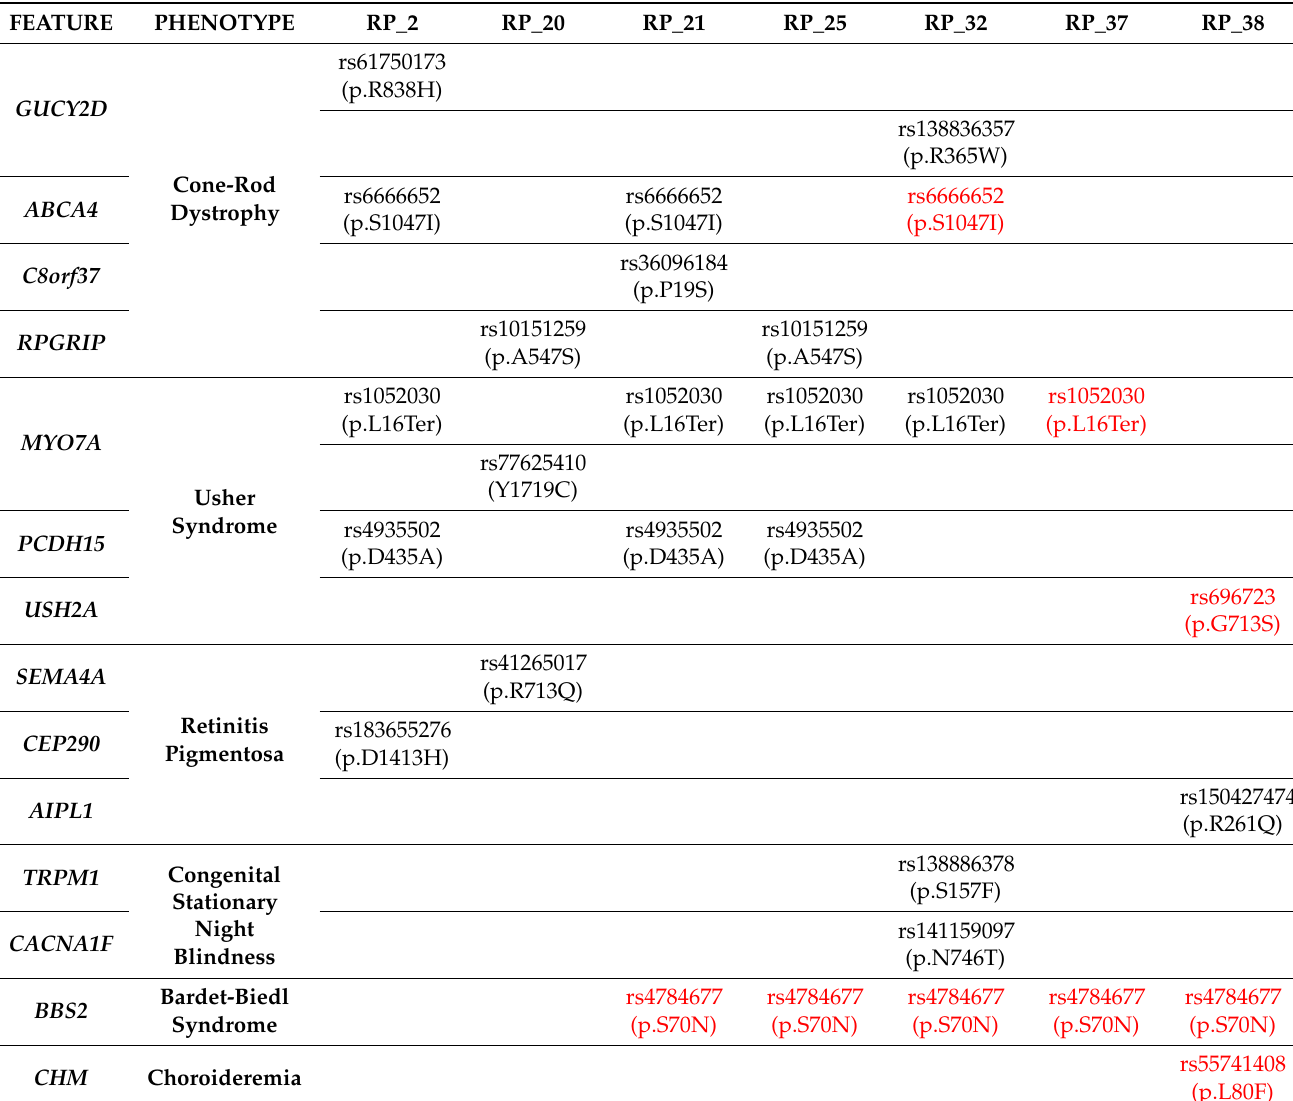
Table 2. Identified causative variants in the probands of the analyzed families. The HGMD professional annotation of whole exome sequencing (WES) detected variants permitted the identification of known causative variants in screened family probands. The homozygous variants are highlighted in red